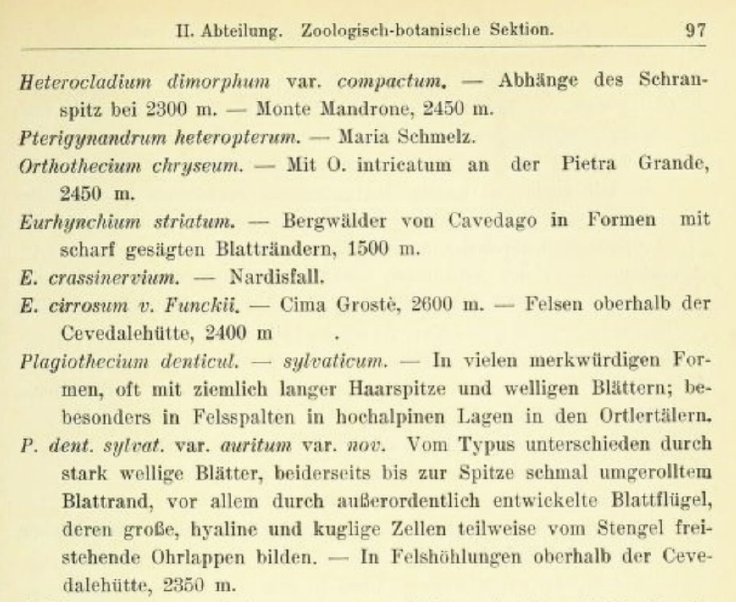
Figure 11. Diagnosis of P . denticulatum var. auritum (Kern 1914).